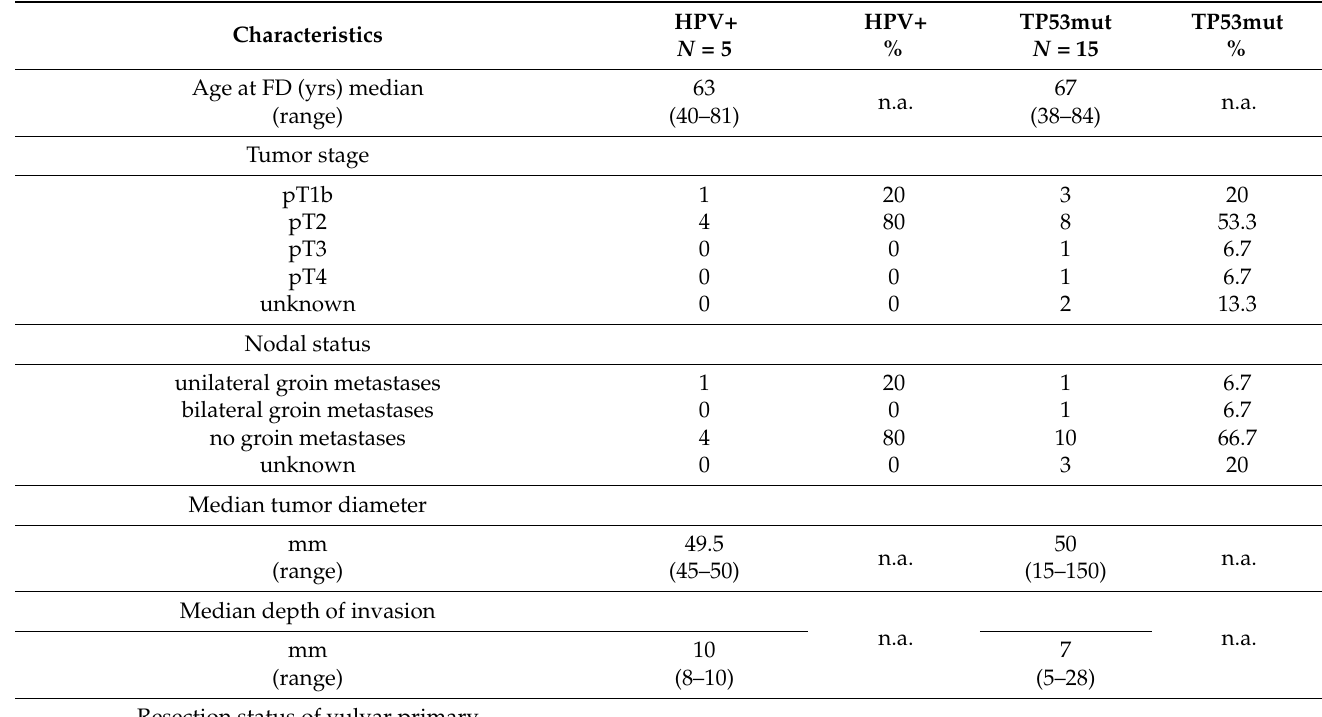
Table 1. Patient characteristics of HPV+ and TP53mut tumors. n.a., not applicable; FD, first diagnosis; yrs, years; SNL, Sentinel (individual patient characteristics are listed in Table